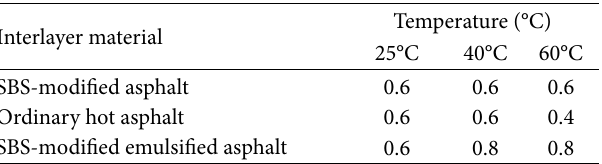
Table 12: Optimum spraying amount for interlayer treatment of